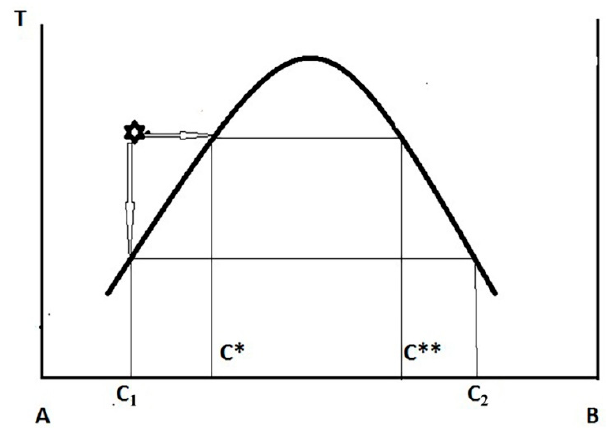
Figure 15. Schematic diagram describing the phase equilibrium in the solvent ( A )–polymer ( B ) system, and the composition of coexisting phases during “cold” and “hot” spinning a cellulose solution. An asterisk indicates the initial position of the dope.